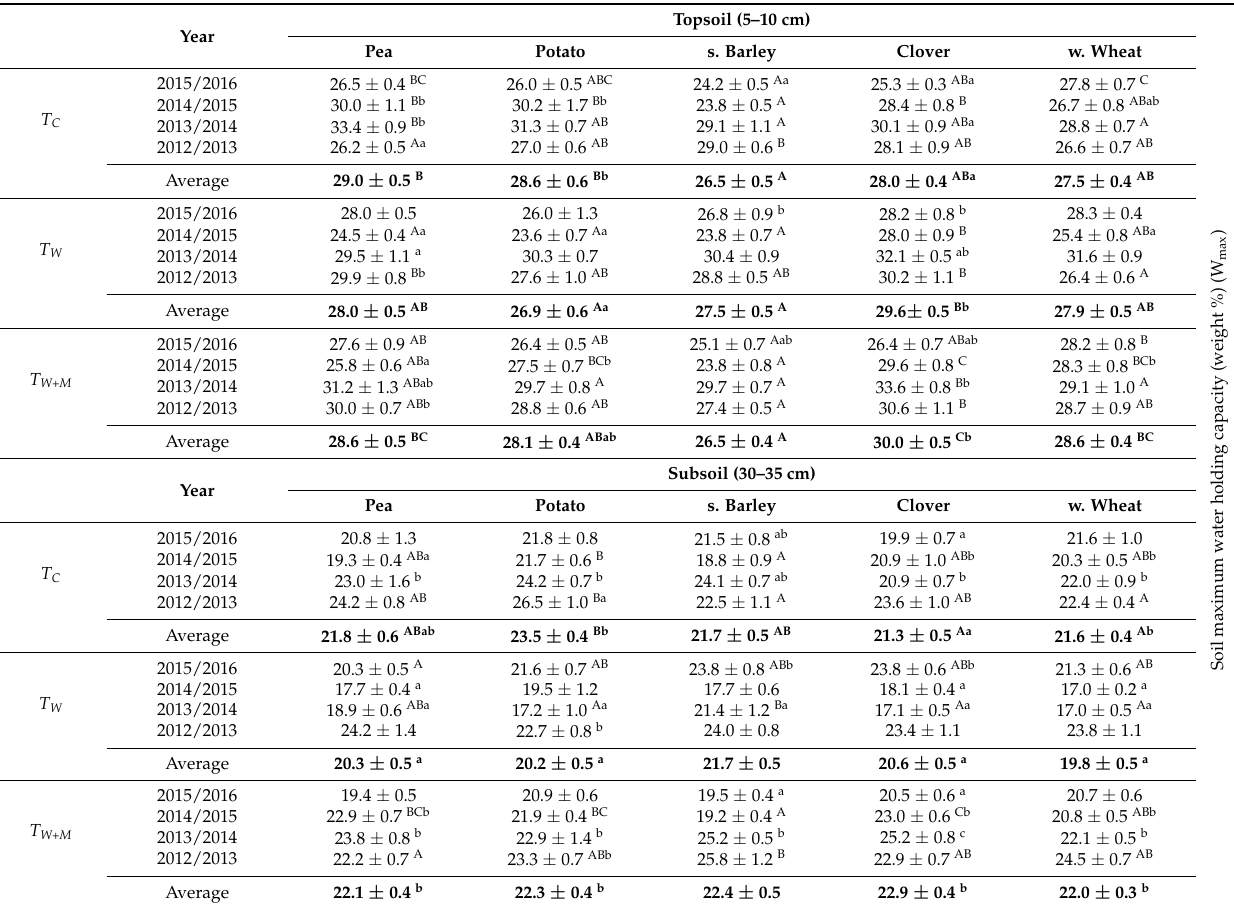
Table 5. The average soil maximum water holding capacity (weight %) with the standard error (SE) of mean in the topsoil (5–10 cm) and subsoil (30–35 cm) by crops, winter cover crop management system and years.